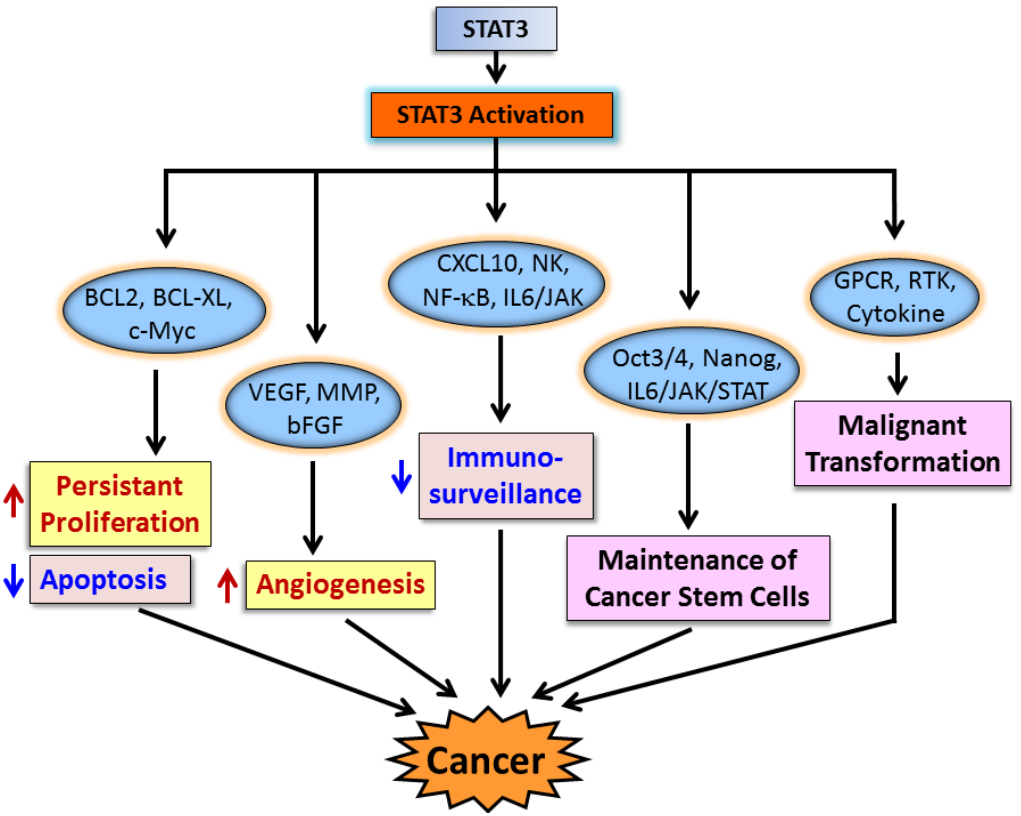
Figure 2. Schematic mechanisms stat3 contributing to